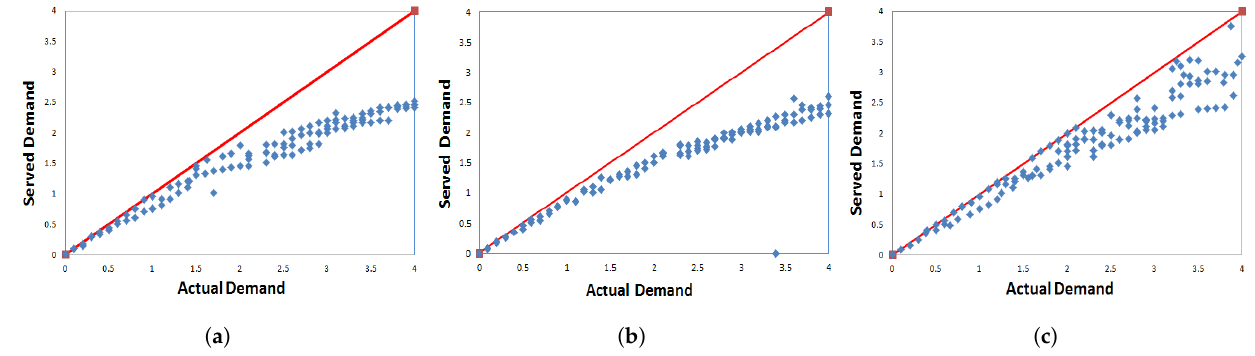
Figure 1. Correlation of demand and supply: ( a ) DRRPV, ( b ) DRRPT, and ( c ) DRRPVT.